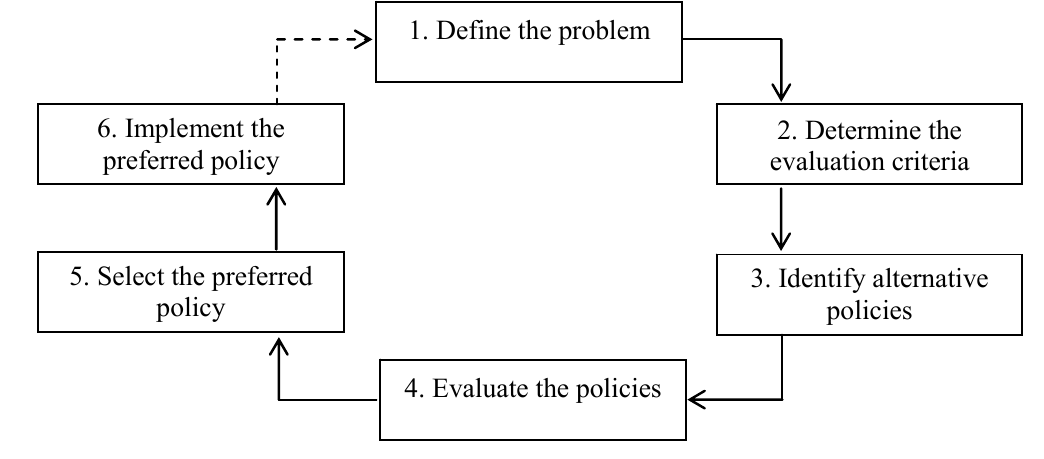
Figure 1. Public policy analysis in six steps [12].